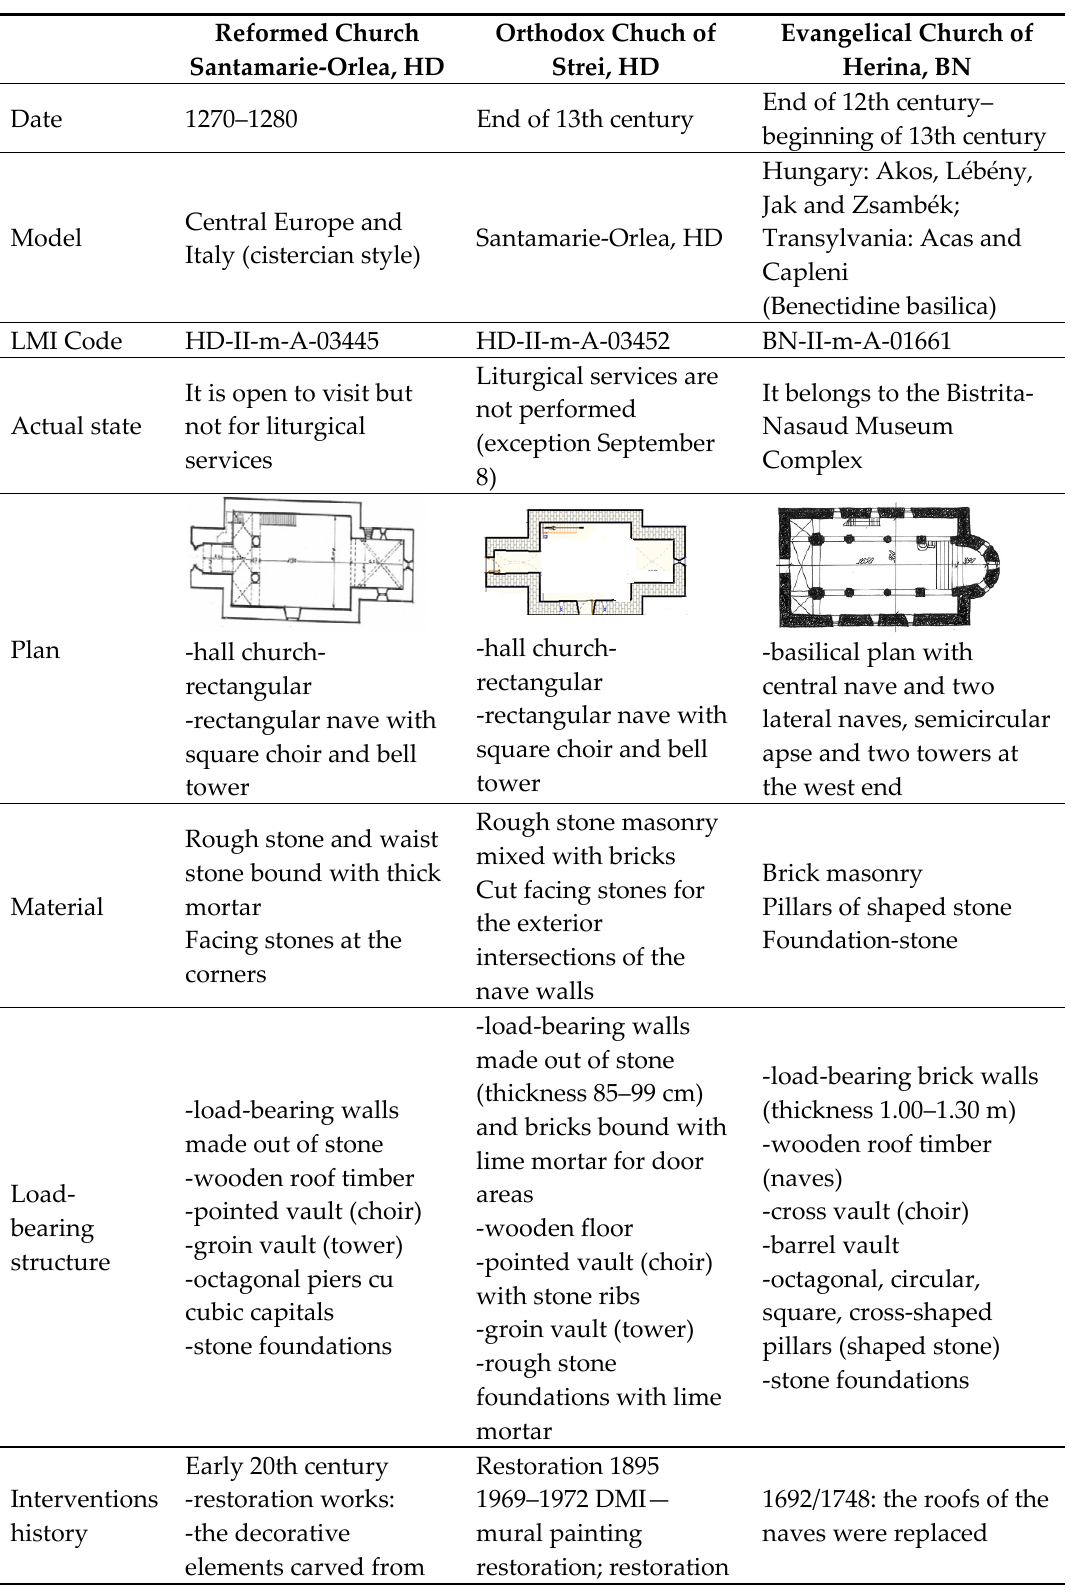
Table 1. Summary of applied